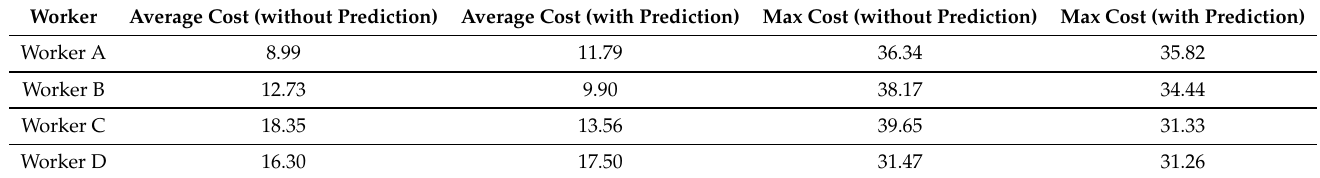
Table 1. Summary of HRI-based costs during the human-following motion for each worker. Worker Average Cost (without Prediction) Average Cost (with Prediction) Max Cost (without Prediction) Max Cost (with Prediction) Worker A 8.99 Worker B Worker C Worker